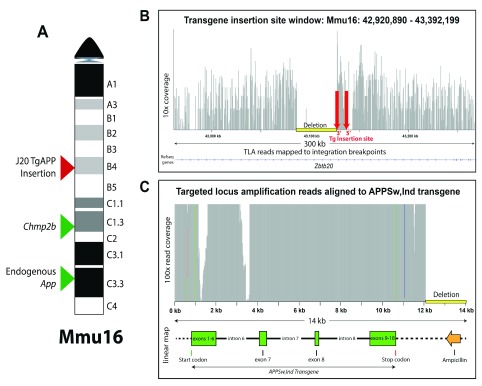
Insertion site of the J20 APP transgene (Tg) on mouse chromosome 16.(
A) Representation of Mmu16 showing insertion site of the J20 Tg array. Also shown are the positions of endogenous mouse
App and
Chmp2b. (
B) TLA applied to the APPSwInd transgene in the J20 mouse. Read mapping to the mouse (mm10) genome assembly shows the exact Tg insertion site (red arrows) with associated genomic deletion (yellow bar). Gene annotation is shown below labelling a small portion of intron 1 of the
Zbtb20 gene. (
C) TLA reads mapped to the APP Tg sequence. Complete coverage was achieved, showing that head to tail concatemerization of the Tg has occurred at position 12088 ablating the ampicillin cassette of the plasmid construct. Coloured lines represent SNPs found in the Tg sequence compared to the published sequence. A linearised map of the plasmid construct is shown below.